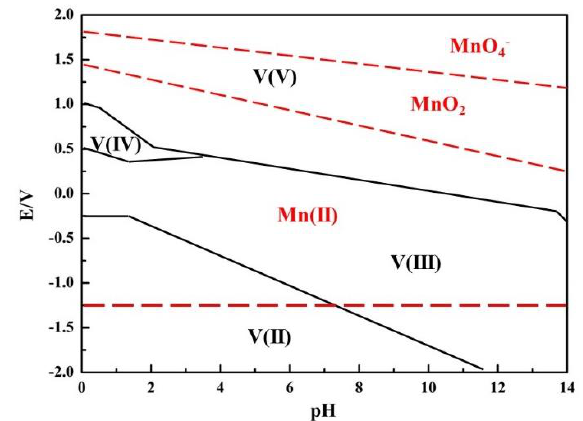
Figure 4. Potential-pH diagram of vanadium and manganese at 25 °C.